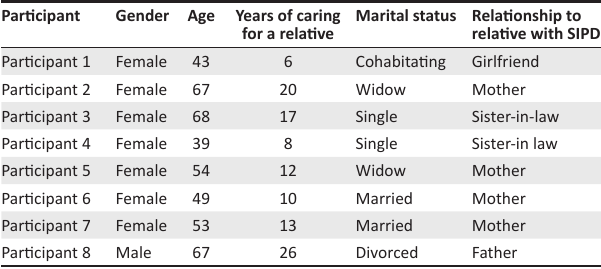
TABLE 1: Participants’